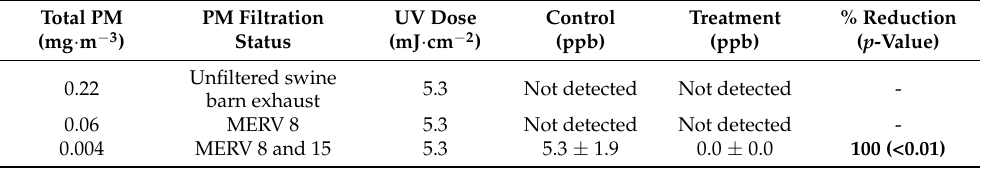
Table 13. Performance of UV-A photocatalysis in mitigating O 3 concentrations under different PM signifies statistical